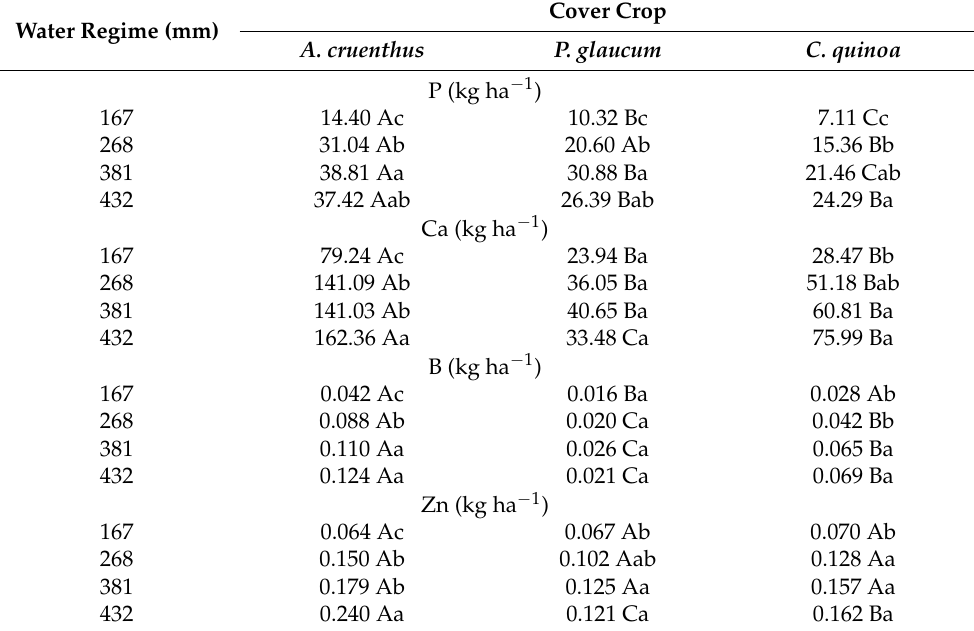
Table 3. Interaction between the water regime and cover crops in the accumulation of phosphorus (P), calcium (Ca), boron (B) and zinc (Zn) in the shoot biomass of the three cover crop species. Cover Water Regime (mm)